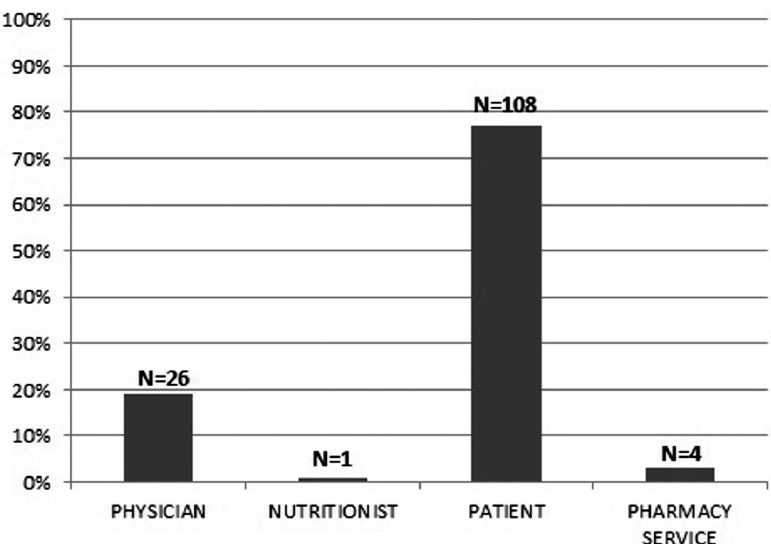
FIGURE 3 - Classes contacted in Pharmaceutical Interventions carried out by the Pharmaceutical Care Service for kidney and liver transplant patients in the period of April – October/2011 in Fortaleza – TABLE V - Classification according to Sabater et al. (2005) and Riba et al . (2000) of pharmaceutical interventions performed by the Pharmaceutical Care Service for kidney transplant patients in the period of April/2011 – October/2011 in Fortaleza – Ceará Classification of PI types according